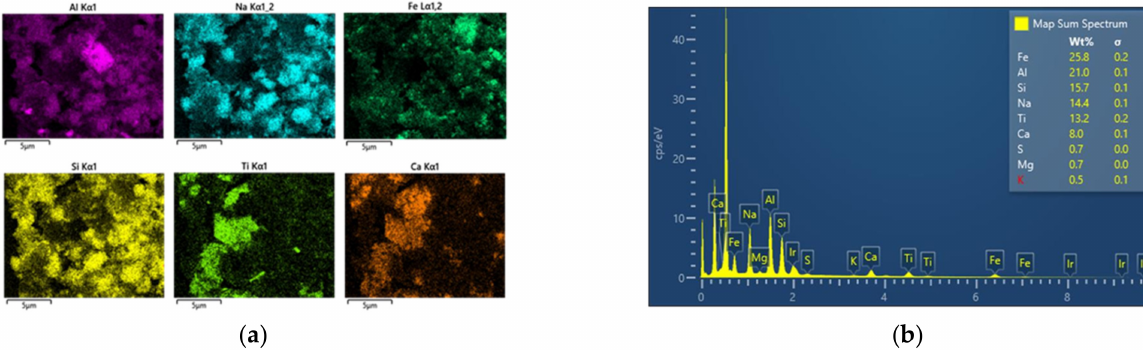
Figure 9. ( a ) X-ray mapping of ETI BR (10 kV, 15 Kx). ( b ) EDS spectrum of ETI